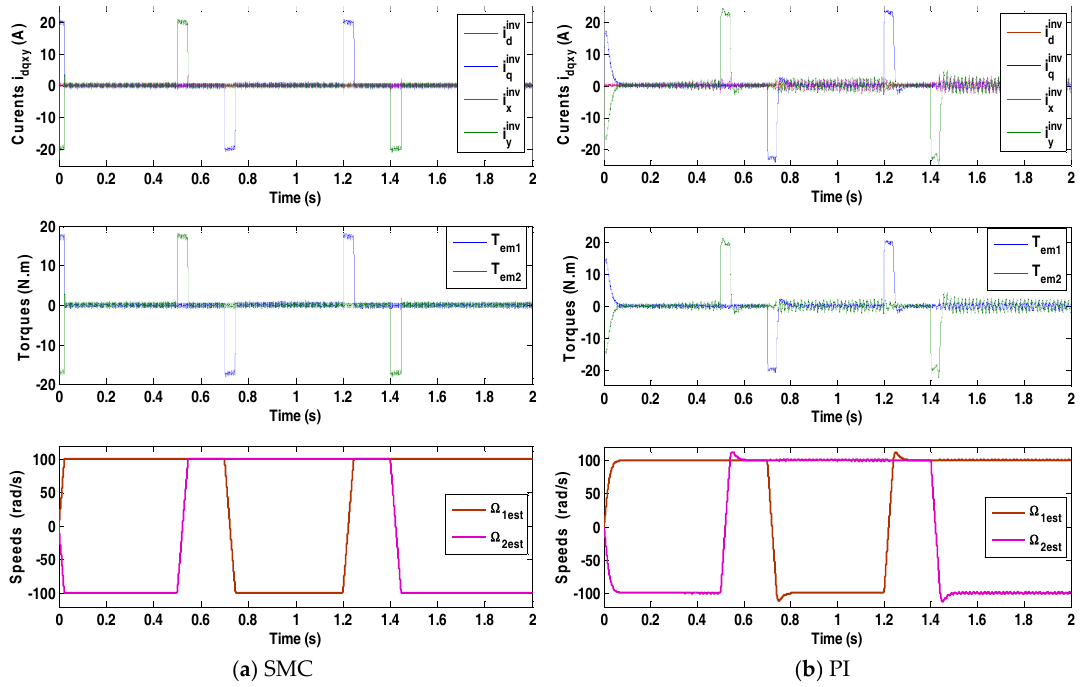
Figure 8. Dynamic responses of parallel-connected two five-phase PMSMs system: when the two motors are operating in the opposite directions.